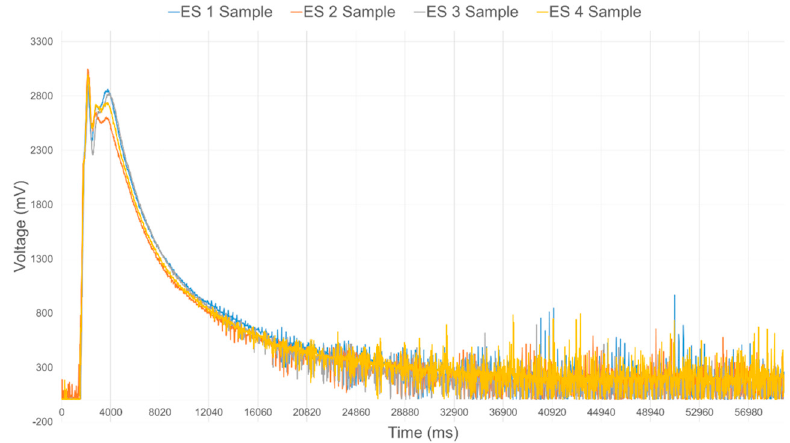
Figure 9. Raw response of four individual IR range sensors over the full range of operation.